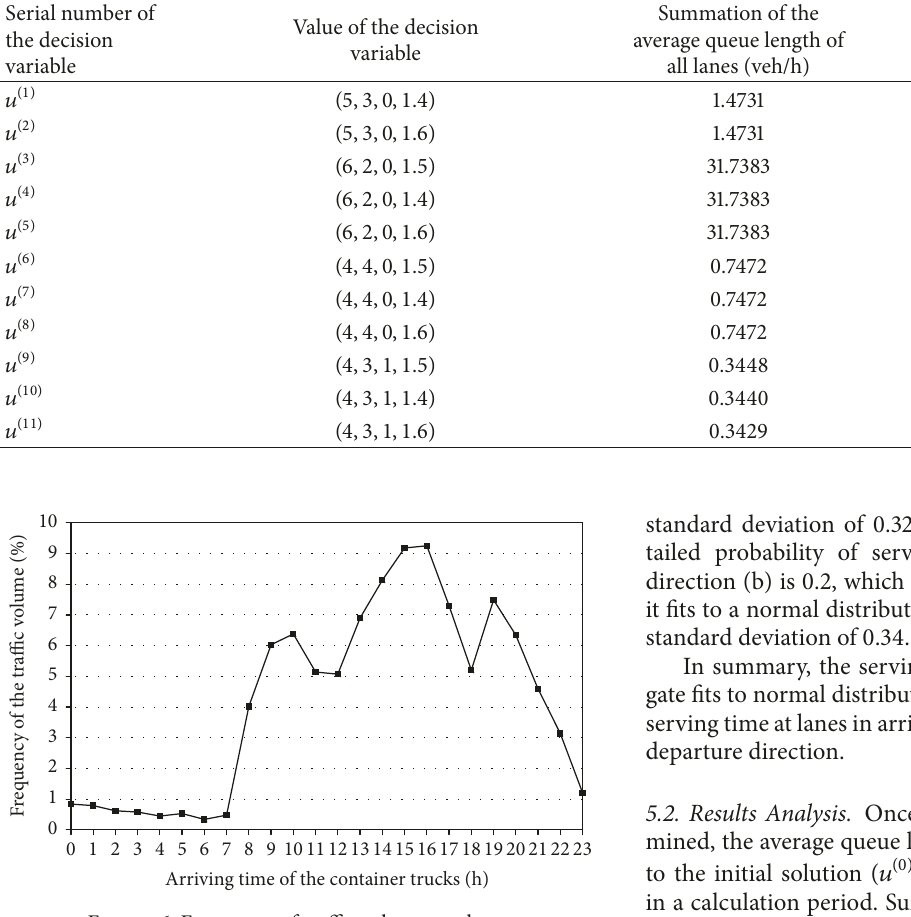
Figure 6: Frequency of traffic volume per